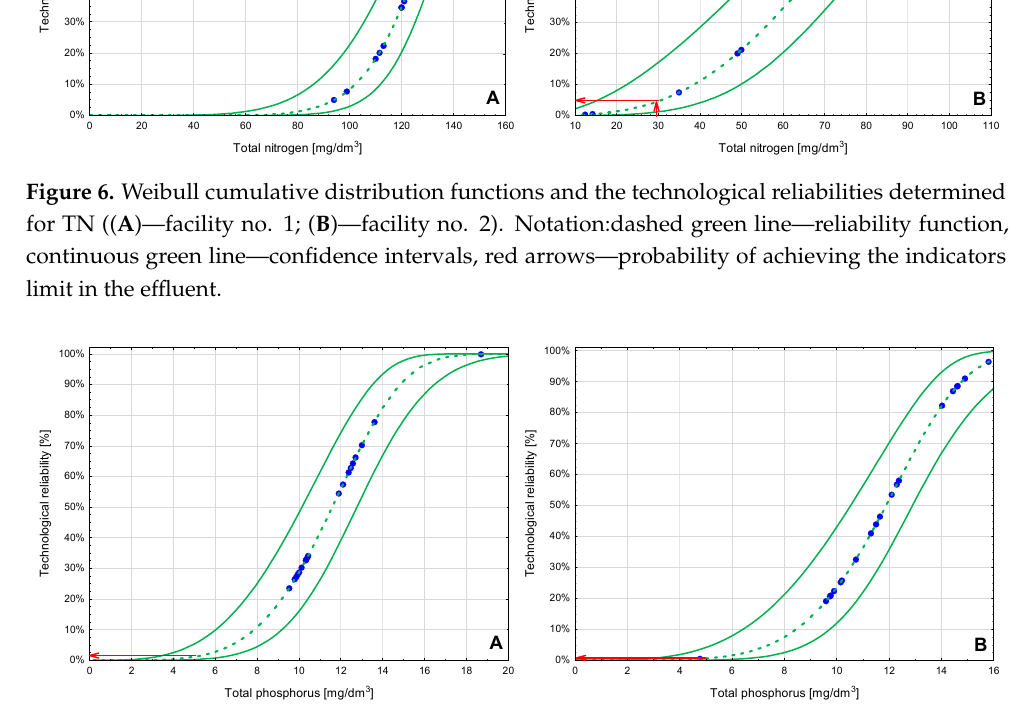
Figure 7. Weibull cumulative distribution functions and the technological reliabilities determined for TP (( A )—facility no. 1; ( B )—facility no. 2). Notation: dashed green line—reliability function, continuous green line—confidence intervals, red arrows—probability of achieving the indicators limit in the